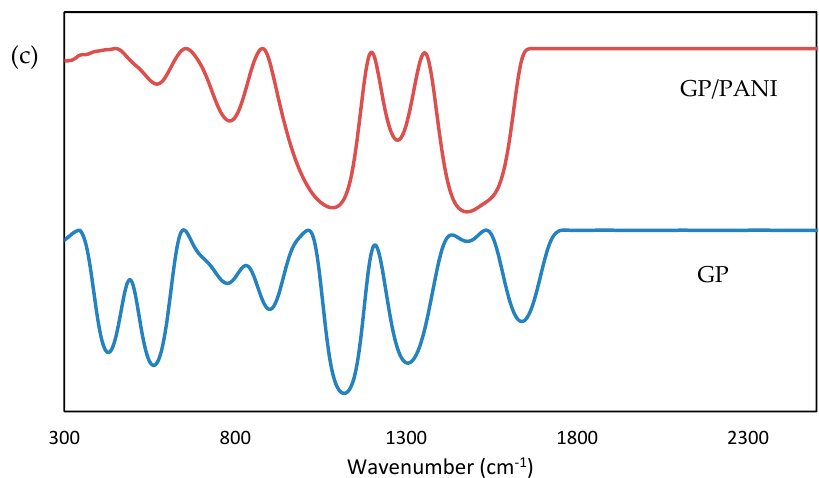
Figure 2. FESEM images of ( a ) graphene and ( b ) GP/PANI nanocomposite with magnification of 50k. ( c ) IR spectra of GP nanosheet and GP/PANI nanocomposite.